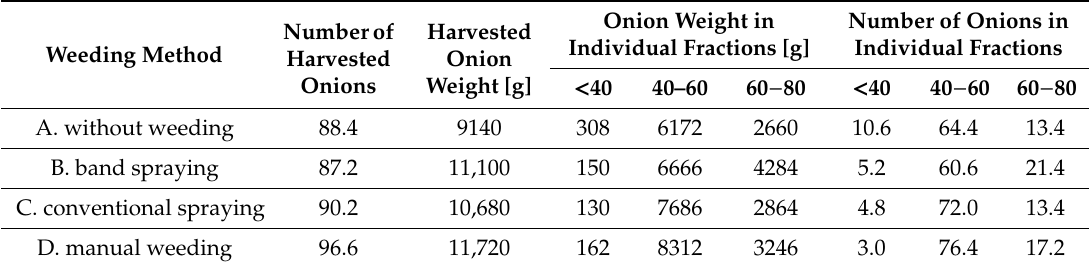
Table 2. Average values for all plot